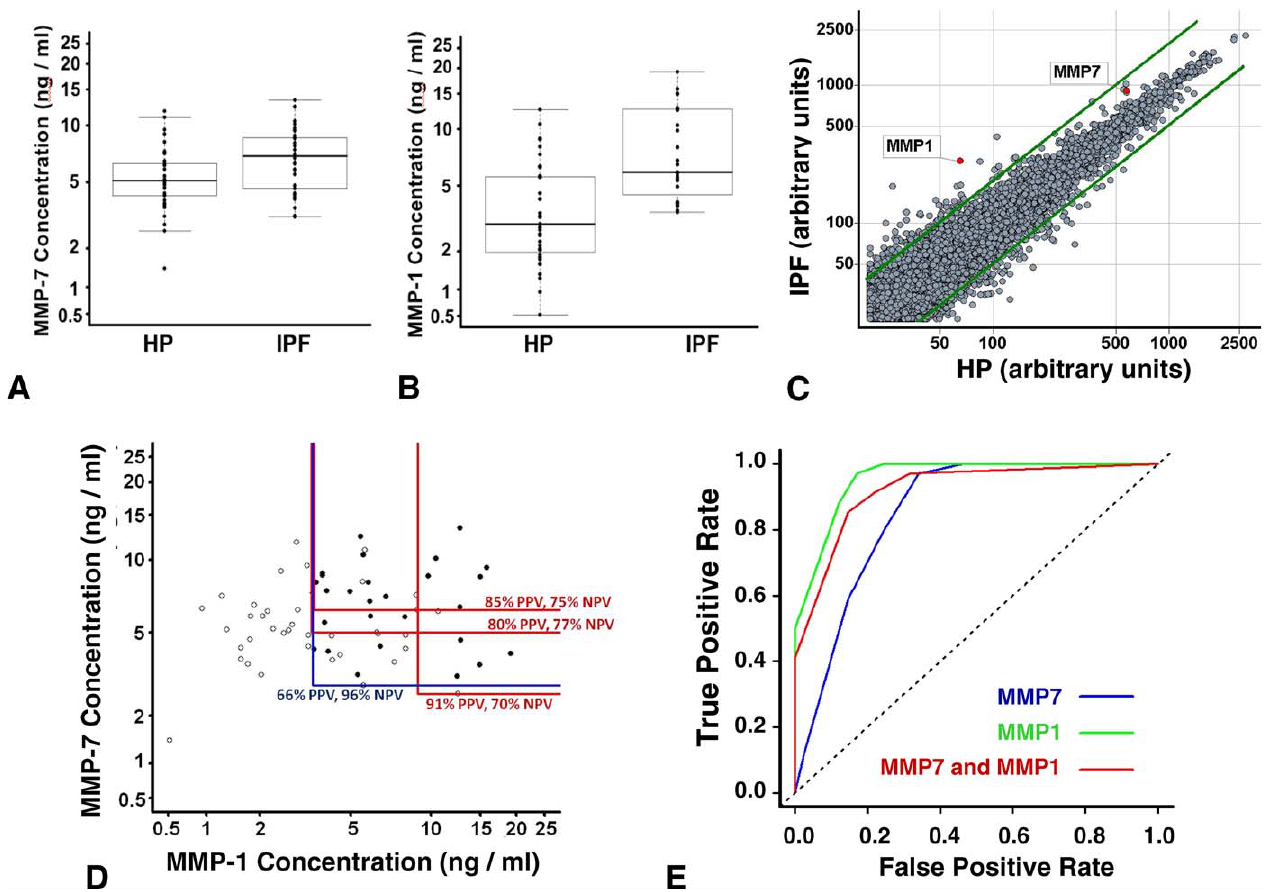
Figure 4. MMP7 and MMP1 Serum Concentrations Are Higher in IPF, Compared to HP (A and B) Concentrations (ng/ml) of MMP7 (A) and MMP1 (B) in the blood are significantly higher in patients with IPF ( n ¼ 34) than in patients with HP ( n ¼ 41). (C) Average gene expression levels (log scale) in IPF samples ( y -axis) compared to HP ( x -axis) measured by gene expression microarrays. Gray circles, all genes on the array; red circles, MMP1 and MMP7. Green oblique lines denote 2-fold change. (D) Combinations of serum MMP7 ( y -axis) and MMP1 concentrations ( x -axis) in IPF (closed circles) and HP patients (open circles). Corners represent points in which the trade-off between positive predictive value (PPV) and negative predictive value (NPV) are optimal for ruling out IPF (blue) or concluding IPF (red) on the basis of MMP1 and MMP7 concentrations. (E) ROC curves for using MMP1 or MMP7, or their combination, to classify samples as IPF or HP. Sensitivity, or true positive rate, is plotted on the y -axis, and false positive rate, or 1 (cid:2) specificity, on the x -axis. The identity line at 45 8 represents a marker that performed no better than classifying samples as IPF or HP by flipping a fair